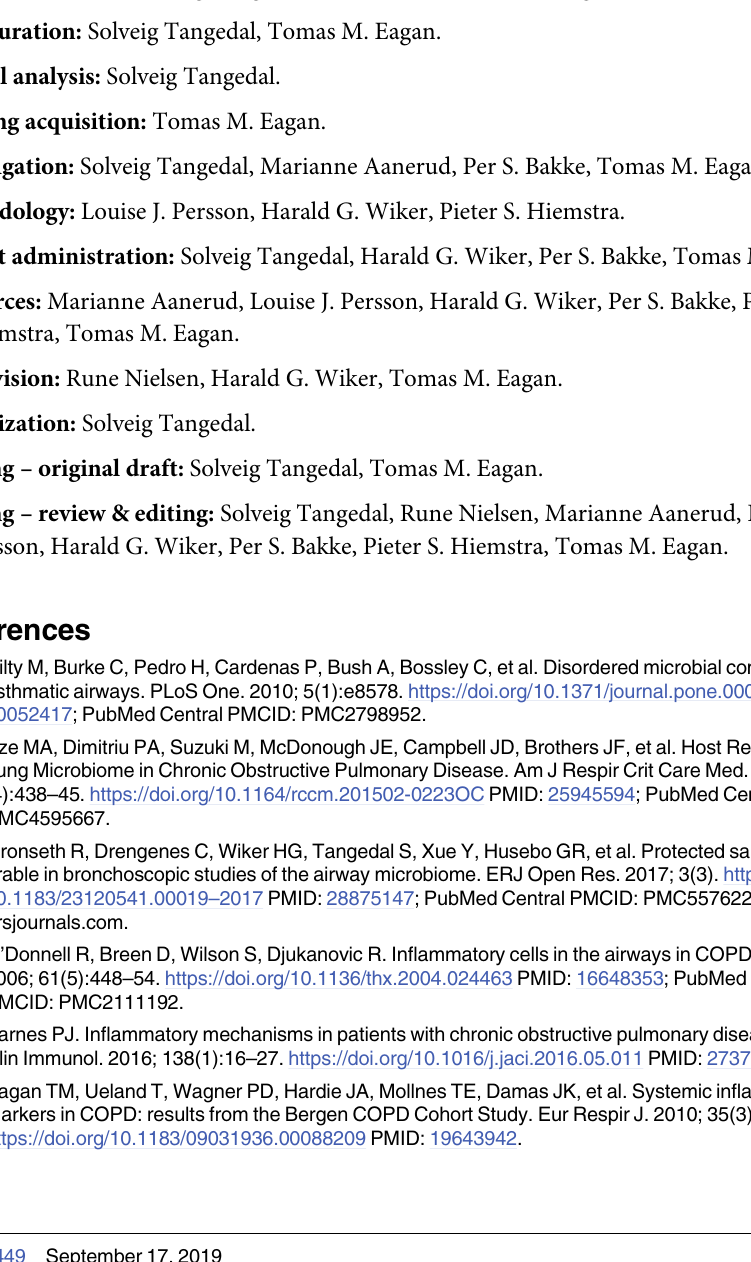
S1 Table. P-values for differential abundances of features between disease states at differ- ent taxonomic levels evaluated by use of Aldex2 in R. p � : FDR-corrected p-values,